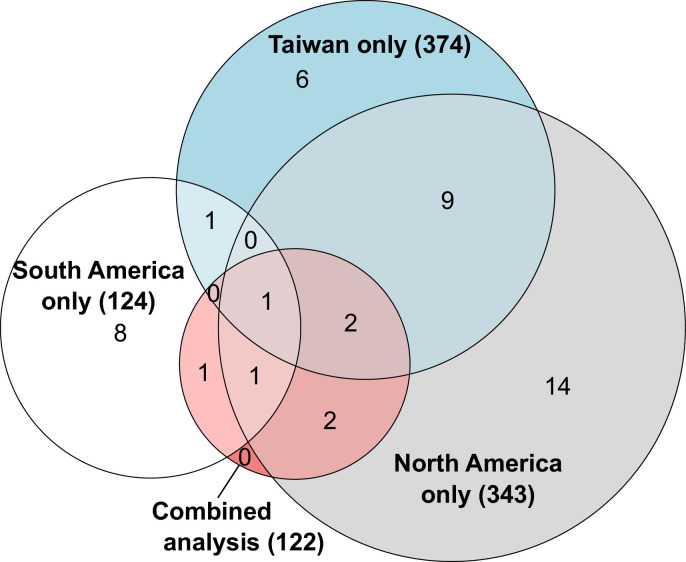
Overlapping number of genes with allele-specific expression according to comparisons in each population independently or after combining data from all populations.The combined analysis detected seven genes with allele-specific expression across both populations, three of which were independently detected using only South American populations, six using only North American populations and three using only Taiwanese populations. The numbers in parentheses indicate how many genes analyzed in each comparison.